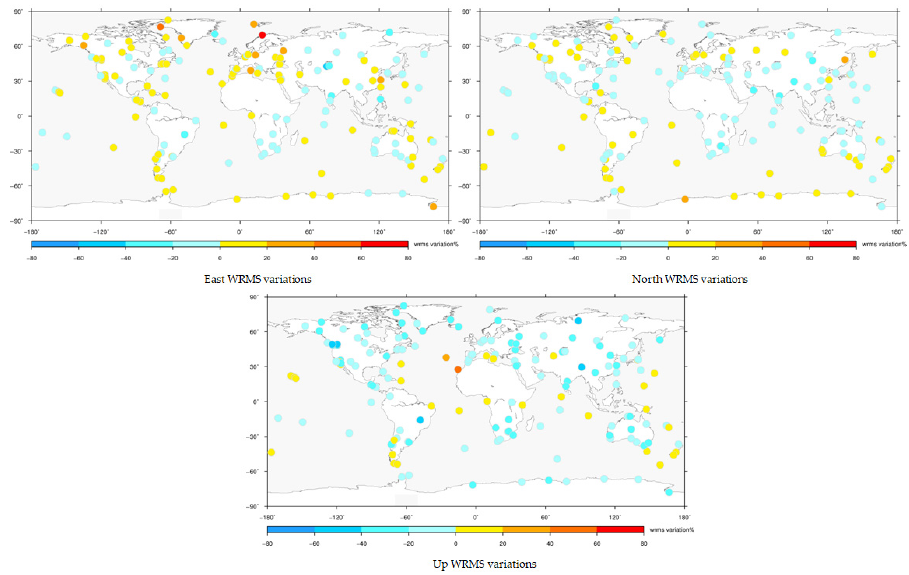
Figure 9. WRMS reductions obtained for the east, north and vertical components using GRACE-derived deformations corrections.